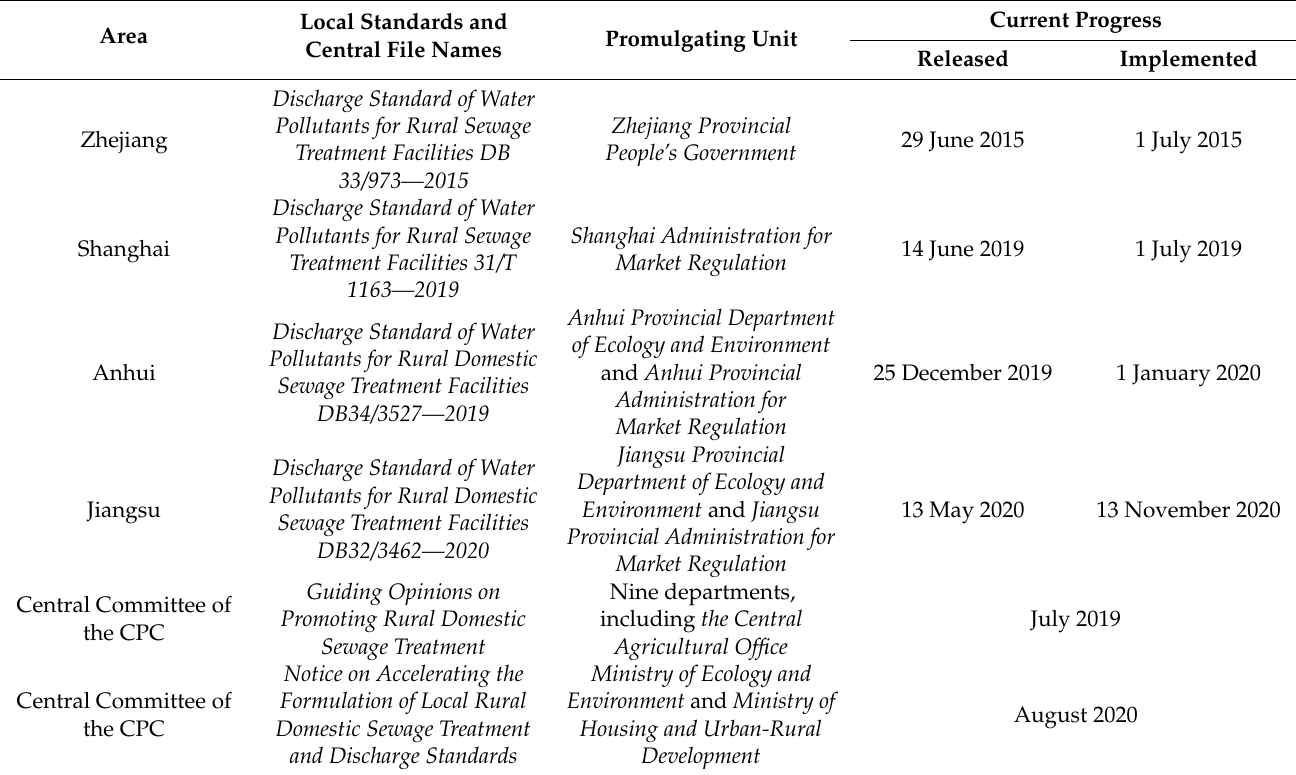
Table 4. Formulation of local standards and central documents for rural domestic sewage treatment in the YRD.